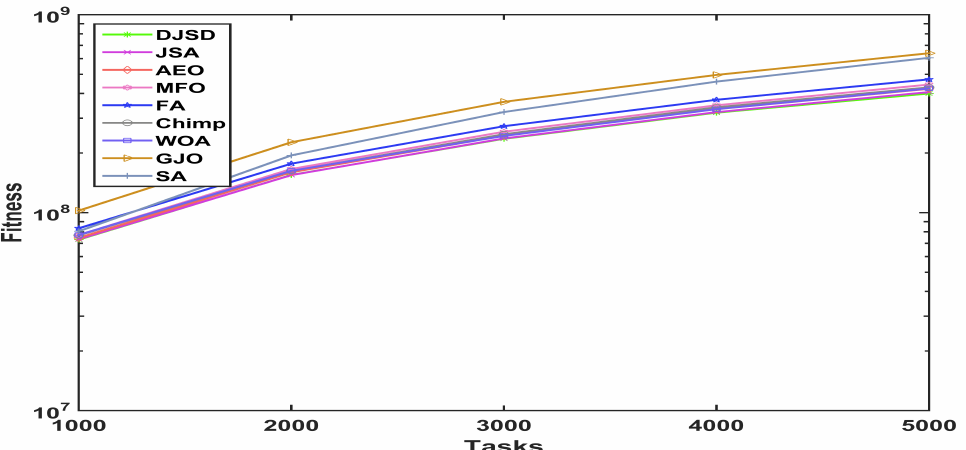
Figure 6. Convergence curve for HPC2N real